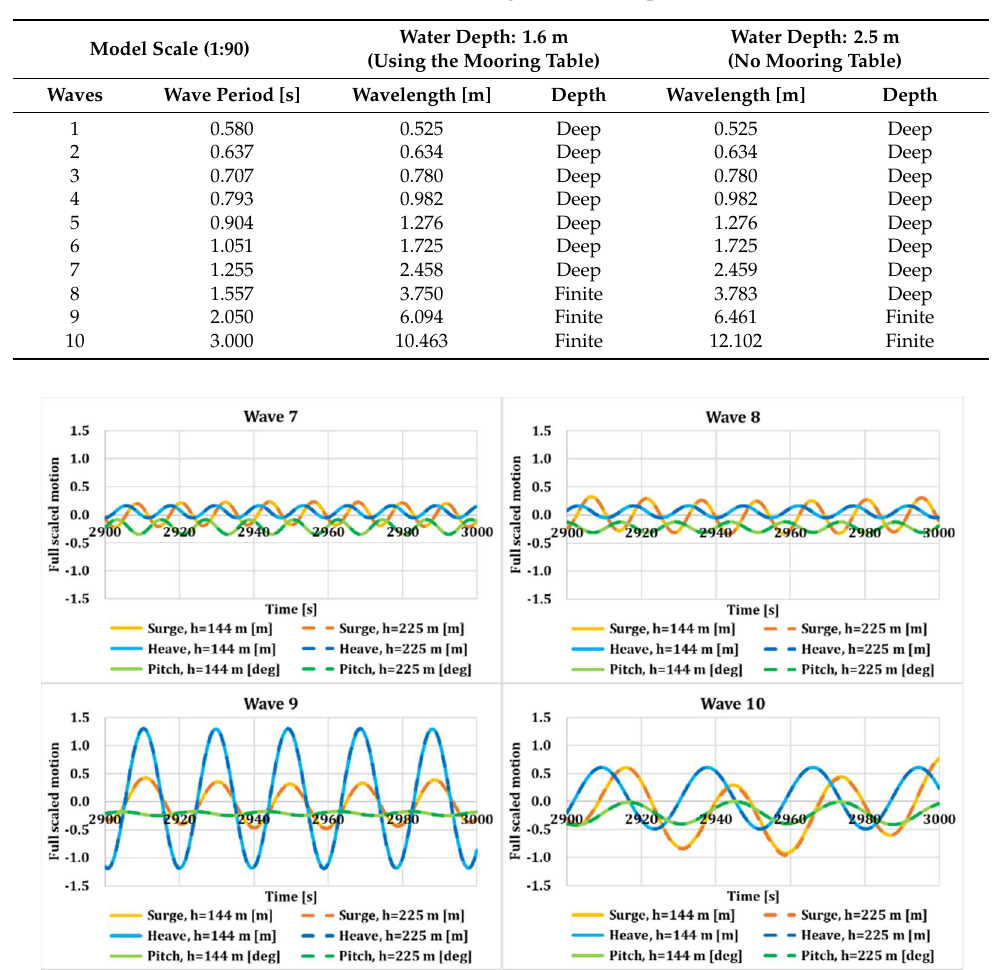
Figure 4. Surge, heave, and pitch motions for two water depths.